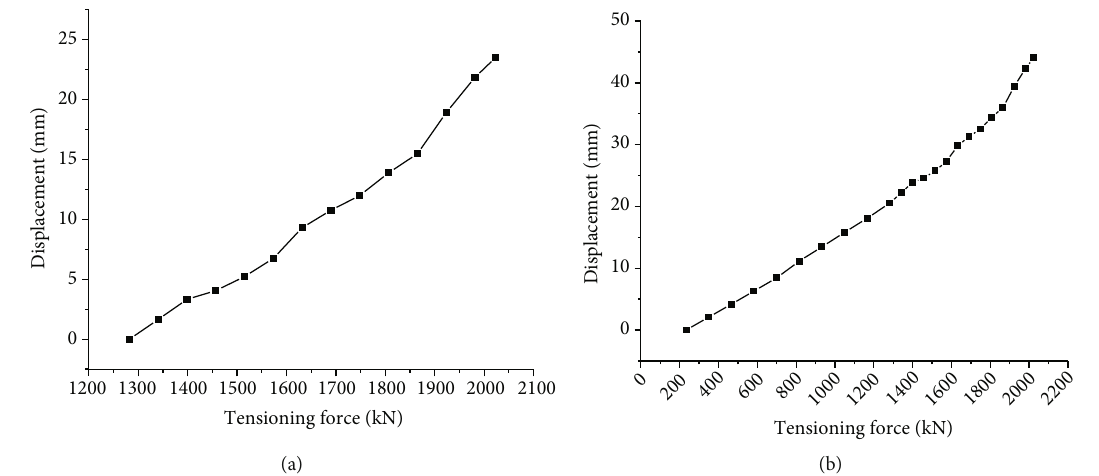
Figure 10: The relationship between the elongation and the tensioning force: (a) only the system tensioning and (b) the single bunch tensioning and the system tensioning.